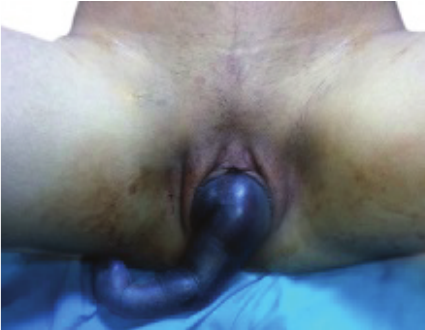
Figure 1: Neglected shoulder presentation at term pregnancy with intrauterine fetal demise. Cyanosed and prolapsed right fetal arm was seen outside of the